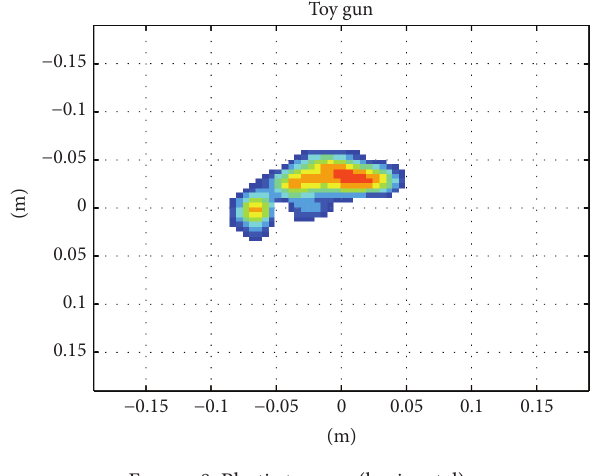
Figure 8: Plastic toy gun (horizontal).